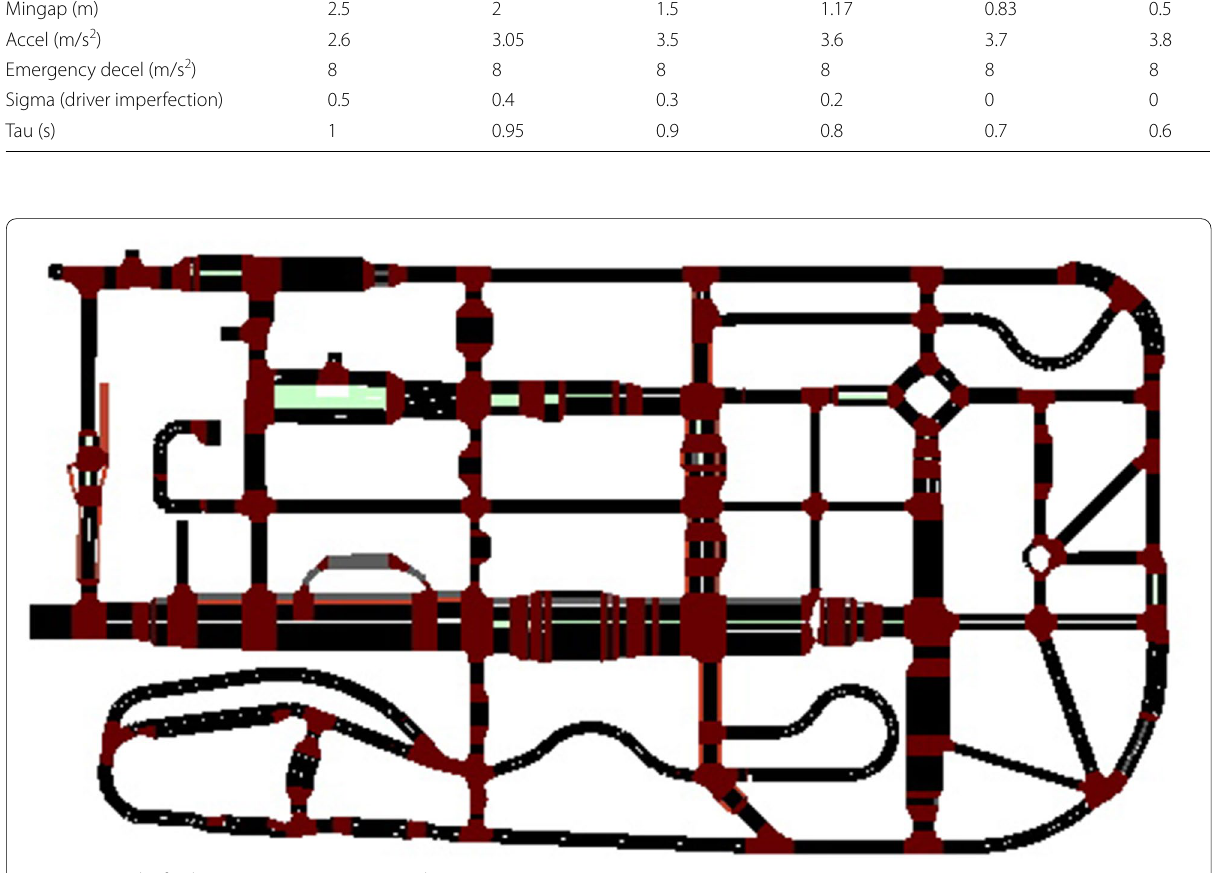
Fig. 3 Network of ZalaZone in SUMO (Source: